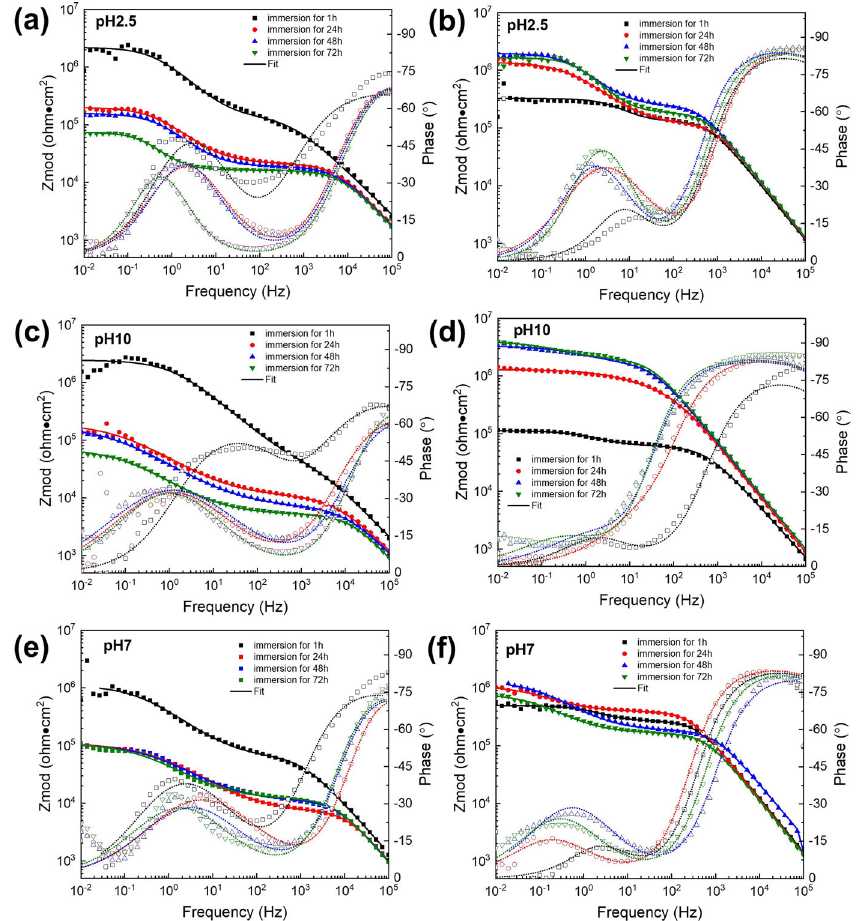
Fig. 4 EIS measurements at different pH conditions. Different coated samples corroded in 5 mM Na 2 SO 4 with varied pH conditions: a Fiber- PVB at pH 2.5; b Ce-Fiber-PVB at pH 2.5; c Fiber-PVB at pH 10; d Ce-Fiber-PVB at pH 10; e Fiber-PVB at pH 7; and f Ce-Fiber-PVB at pH